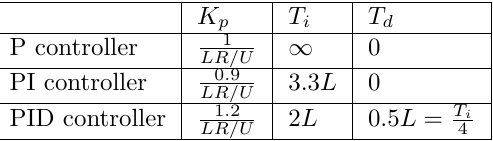
Table 1: Ziegler-Nichols’ open loop method: Formulas for the controller parameters.